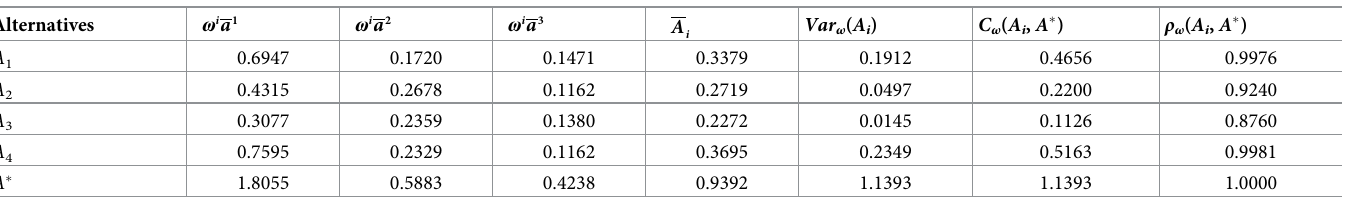
Table 5. Calculation results with respect to the BWM.